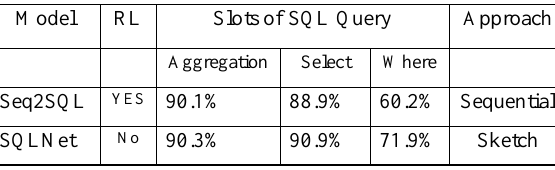
Table 2. Partial comparison between a sequential model and the sketch-based